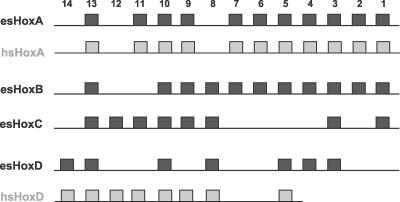
Hox Genes in the Elephant Shark and Horn SharkHox genes belonging to putative four Hox clusters (esHoxA to esHoxD) identified in the elephant shark assembly are shown as dark filled boxes. Linkage of genes is inferred from linkage information in horn shark and other vertebrates. For comparison, horn shark HoxA and HoxD cluster (hsHoxA and hsHoxD) genes (light filled boxes) are shown [51,52]. In the horn shark, only a partial HoxD cluster (from HoxD5 to HoxD14) has been sequenced, and HoxB and HoxC clusters are yet to be sequenced.